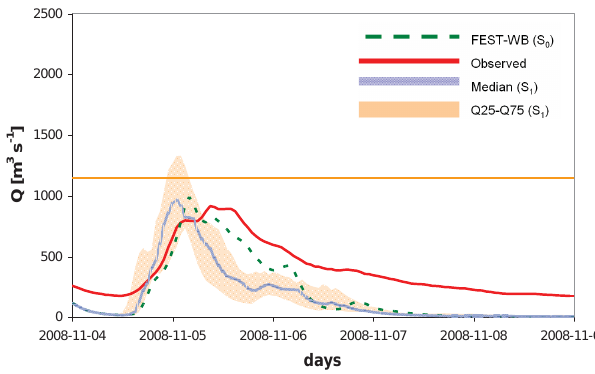
Fig. 5. Forecasted temperature by the COSMO-LEPS model, in comparison with the observed value (red line); the purple line shows the COSMO-LEPS median temperature, the light orange shadows show the COSMO-LEPS 25th and 75th percentile temperature and the black lines refer to the COSMO-LEPS envelope temperature. Values are referred to as the mean area temperatures. The run started on 4 November 2008.